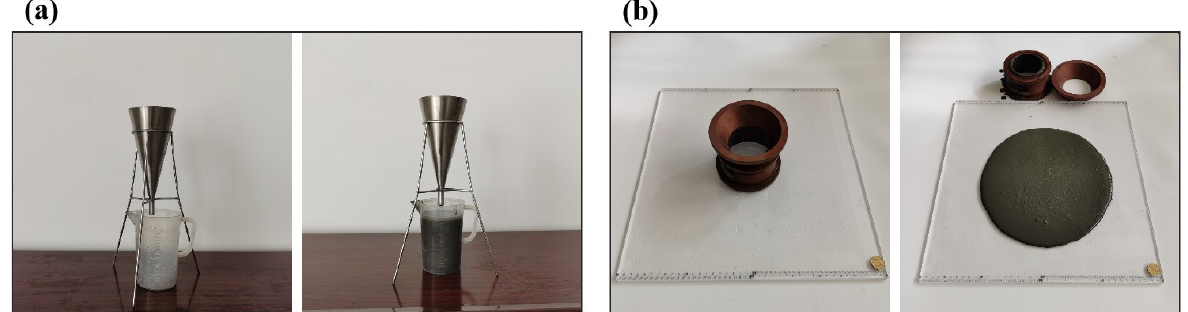
Figure 2. Schematic and photographs of ( a ) Flow time test and ( b ) Flow diameter test.